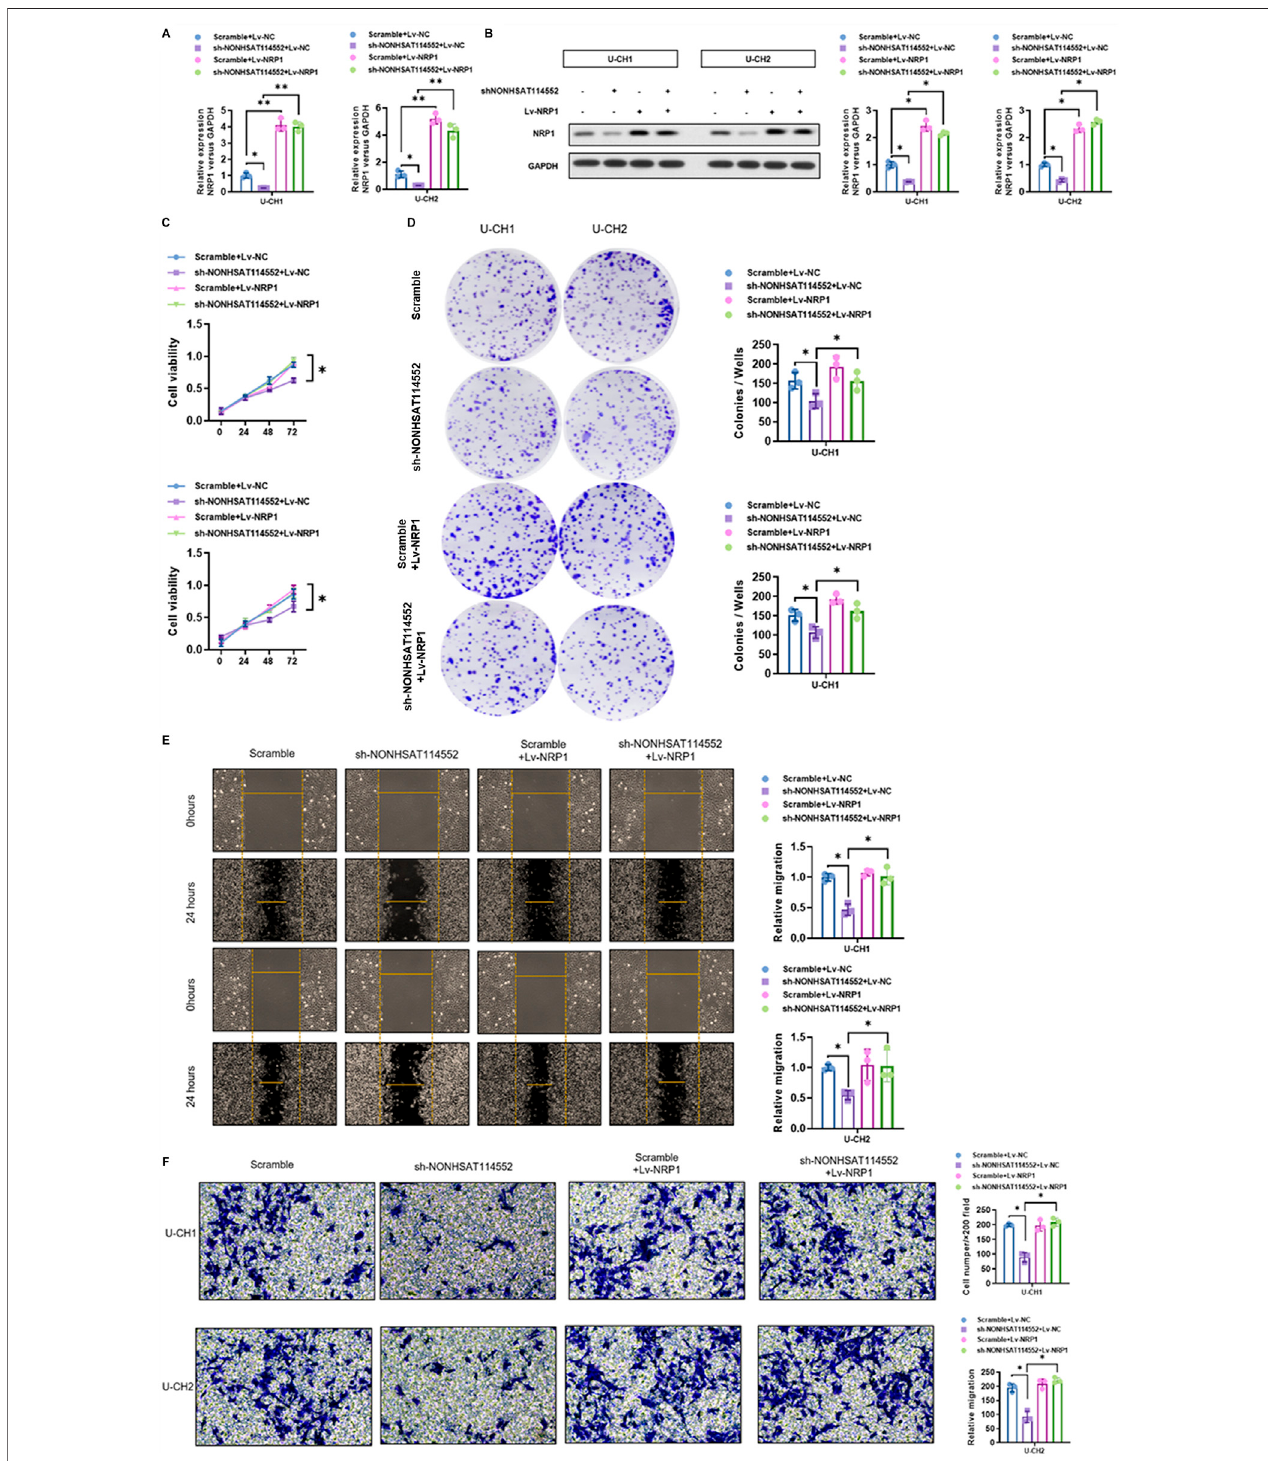
FIGURE 6 | NRP1 alleviated the suppression of NONHSAT114552 on chordoma cell proliferation, invasion and migration (A, B) . NRP1 mRNA and protein expression level was assessed by qRT-PCR and WB in groups of sh-NONHSAT114552+Lv-NRP1, Lv-NRP1, sh-NONHSAT114552 or scramble (C) . Cell viability of U-CH1orU-CH2cellswasdetectedbyCCK8assaysingroupsofsh-NONHSAT114552+Lv-NRP1,Lv-NRP1,sh-NONHSAT114552orscramble (D) .ColonyofU-CH1 or U-CH2 cells was measured by colony formation assays in groups of sh-NONHSAT114552+Lv-NRP1, Lv-NRP1, sh-NONHSAT114552 or scramble (E) . Migration ability of U-CH1 or U-CH2 cells in groups of sh-NONHSAT114552+Lv-NRP1, Lv-NRP1, sh-NONHSAT114552 or scramble was investigated by wound healingassays (F) .ThecellinvasiveabilitychangesofU-CH1orU-CH2cellswereanalyzedbytranswellassaysingroupsofsh-NONHSAT114552+Lv-NRP1,Lv-NRP1, sh-NONHSAT114552 or